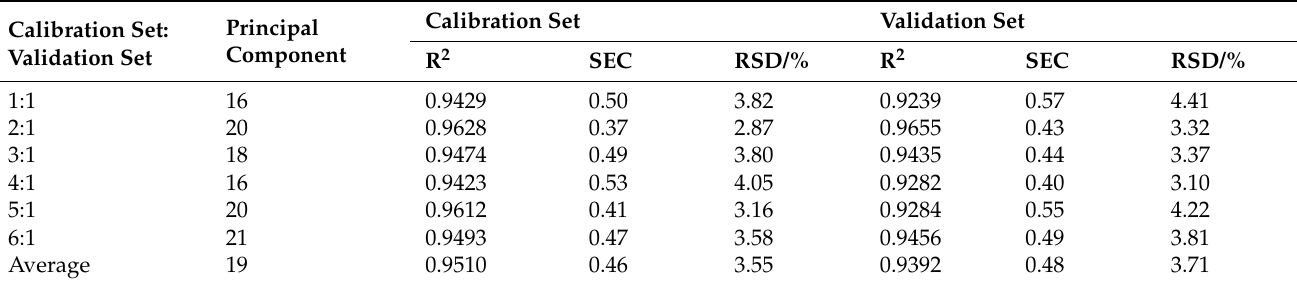
Table 4. NIR prediction results of the model for different samples